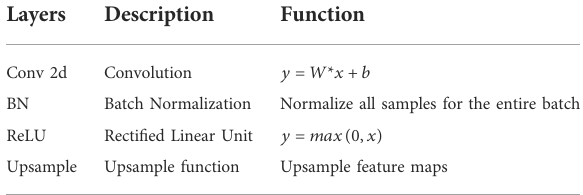
TABLE 2 The speci fi c description of the layers or